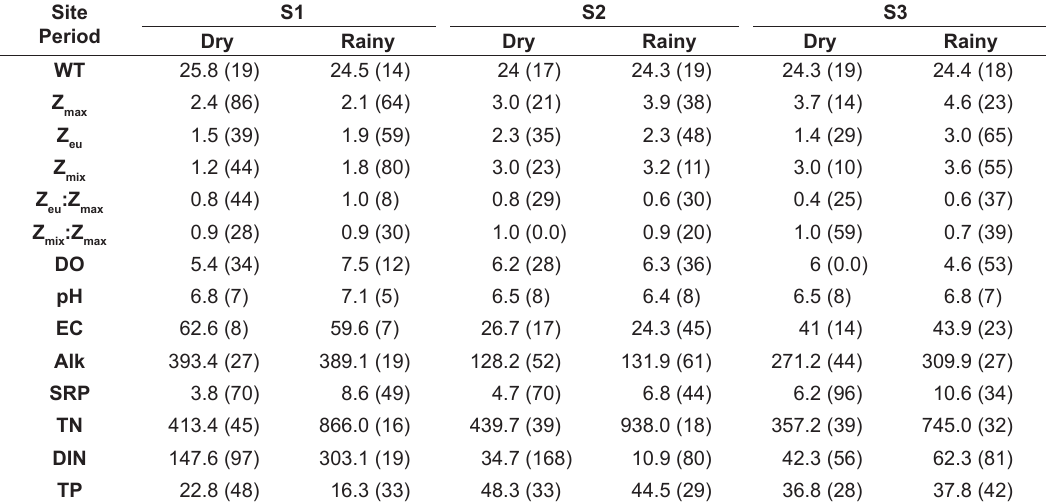
Table 1. Mean values and coefficient of variation in parentheses (%) of the measured environmental factors. S1, lake related to the dammed river (Paraná River); S2 and S3 lakes related to the non-dammed rivers Baia and Ivinhema